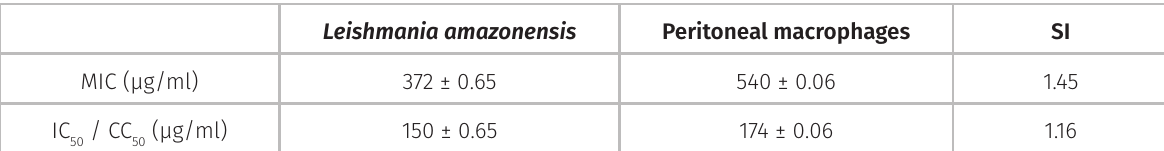
Table I. Inhibition of promastigote growth and peritoneal murine macrophages citotoxicity by D. (S.) latex aqueous